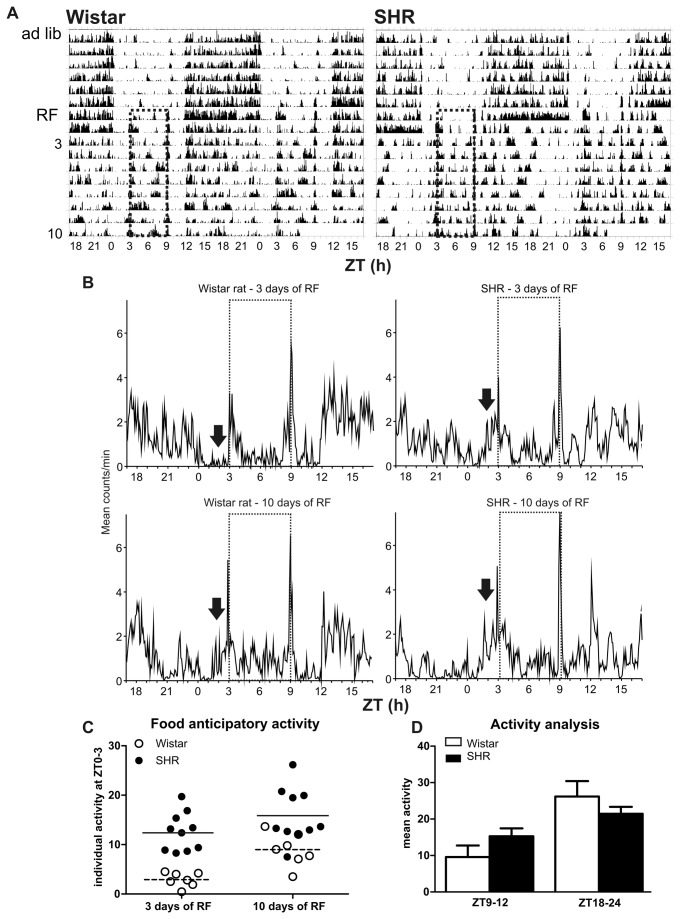
Analysis of the behavioral activity of Wistar rats and SHR maintained under restricted feeding conditions.
A) Representative
double-plotted
actograms of the locomotor activity of a Wistar rat (left) and SHR (right) maintained under LD12: 12. The rats were initially fed ad
libitum (ad lib), and thereafter, food was provided only during a 6-h period between Zeitgeber time (ZT) 3 and ZT9 for 10 days; the 6-h period of restricted feeding (RF) is depicted by the dashed rectangles. B) Cumulative
daily
locomotor
activity
profiles of Wistar rats (left, n = 7) and SHR (right, n = 10) detected on the 3rd day (upper panel) and on the 10th day (lower panel) of RF. The dotted rectangles represent the time of food availability; the arrows point at food anticipatory activity. C) Comparison
of
food
anticipatory
activity measured during the 3-h interval prior to food presentation, i.e., between ZT0 and ZT3, in individual Wistar rats (open circles) and SHR (full circles), expressed as the percent of total activity of each animal. D) Comparison
of
activity
level (expressed as means ± S.E.M. in percent of total activity) in Wistar rats (open column; n = 7) and SHR (full column; n = 10) during the intervals between ZT9 and ZT12, i.e., between the end of the food presentation and the beginning of the dark period, and between ZT18 and ZT24, i.e., during the second half of the dark period.